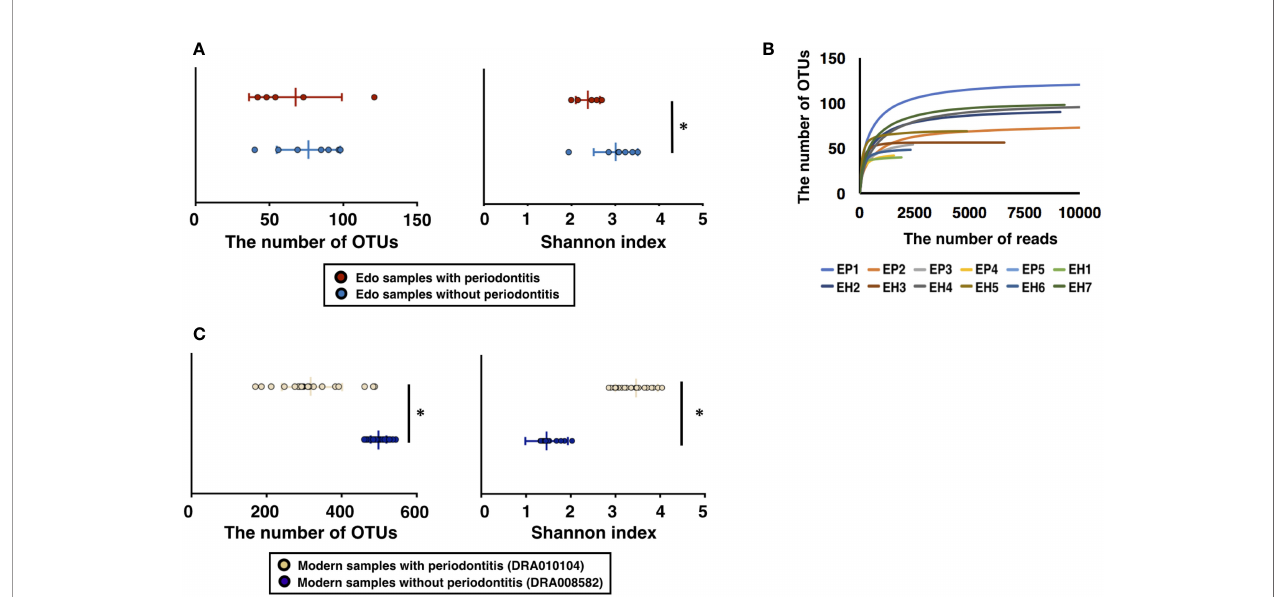
FIGURE 2 | Evaluation of bacterial diversity of ancient Edo sample based on 16S rDNA sequences. (A) The number of operational taxonomic units (OTUs) and Shannon index of Edo samples. (B) Rarefaction curve of Edo samples. (C) The number of OTUs and Shannon index of modern samples. *P < 0.05.